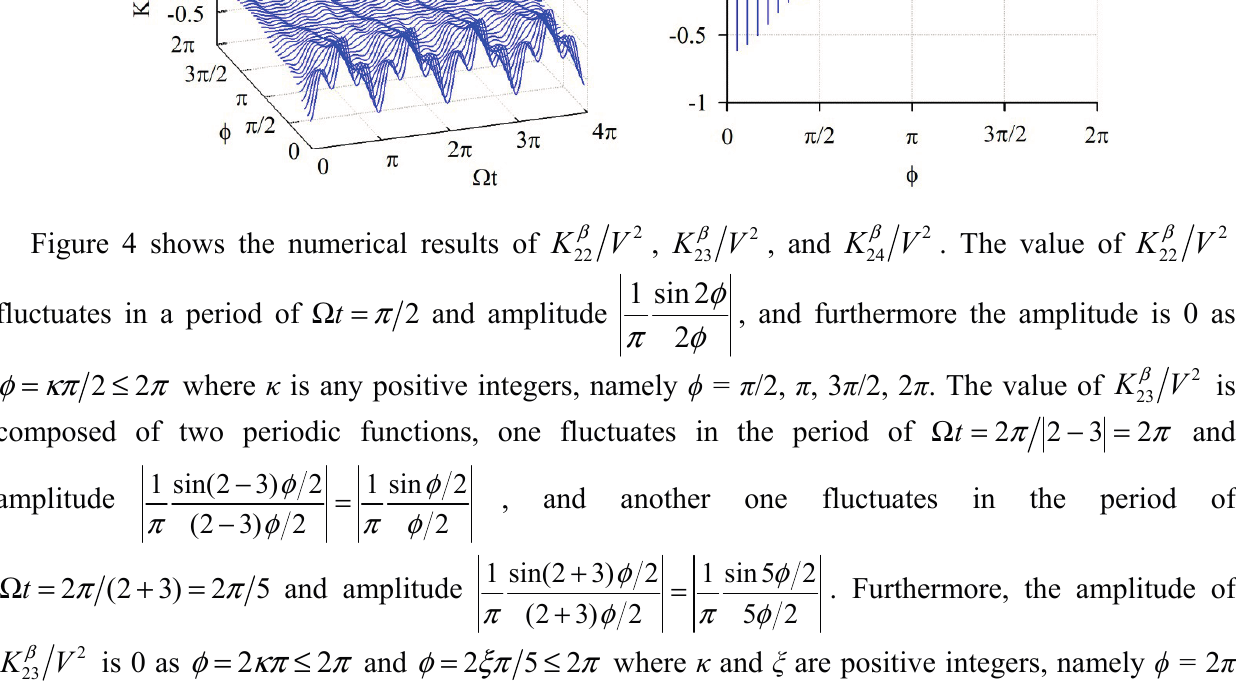
VK α , 2 VK α ) VK α , and 2 22 24 23